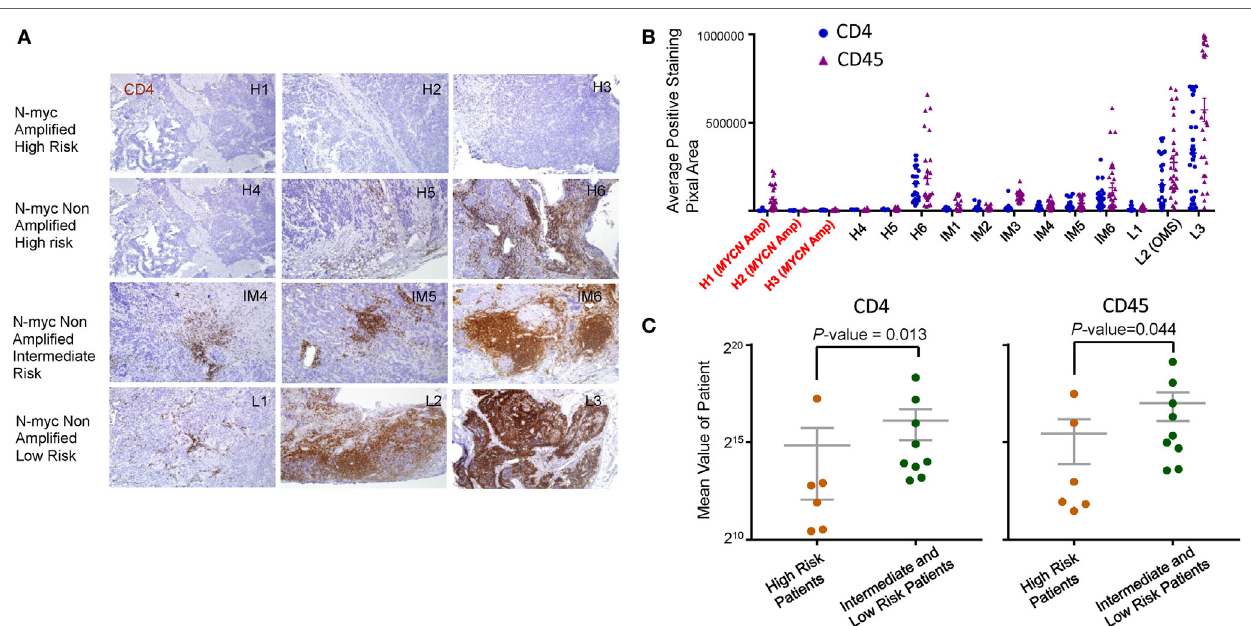
FigUre 5 | Immunohistochemical analysis of leukocyte infiltration in neuroblastoma (NB). (a) Immunohistochemical staining of CD4 (brown) and CD45 (data not shown) was performed on paraffin embedded NB tumor tissue at diagnostic biopsy from MYCN amplified high-risk, MYCN non-amplified high-risk, MYCN non-amplified intermediate, and MYCN non-amplified low-risk tumors. The nuclei were counterstained with hematoxylin (blue). Tissue sections were imaged at × 100 original magnification. The association between CD4, CD45 expression, and MYCN amplification (b) and risk stratification (c) was determined by digital mean density image analysis and the data are graphed. P -values in (c) were calculated with an unpaired Mann–Whitney test.